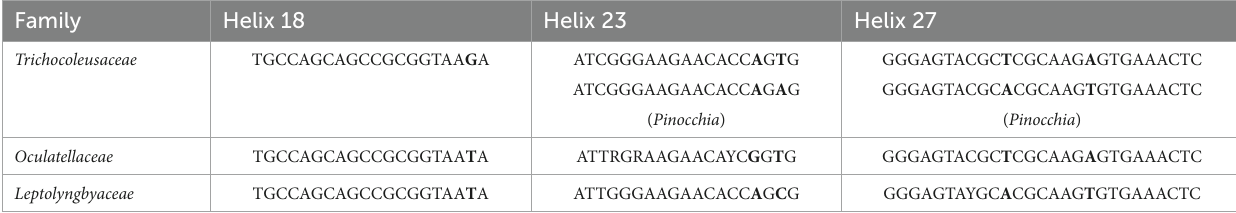
TABLE 2 Nucleotide comparisons of focal helices within 16S rRNA among